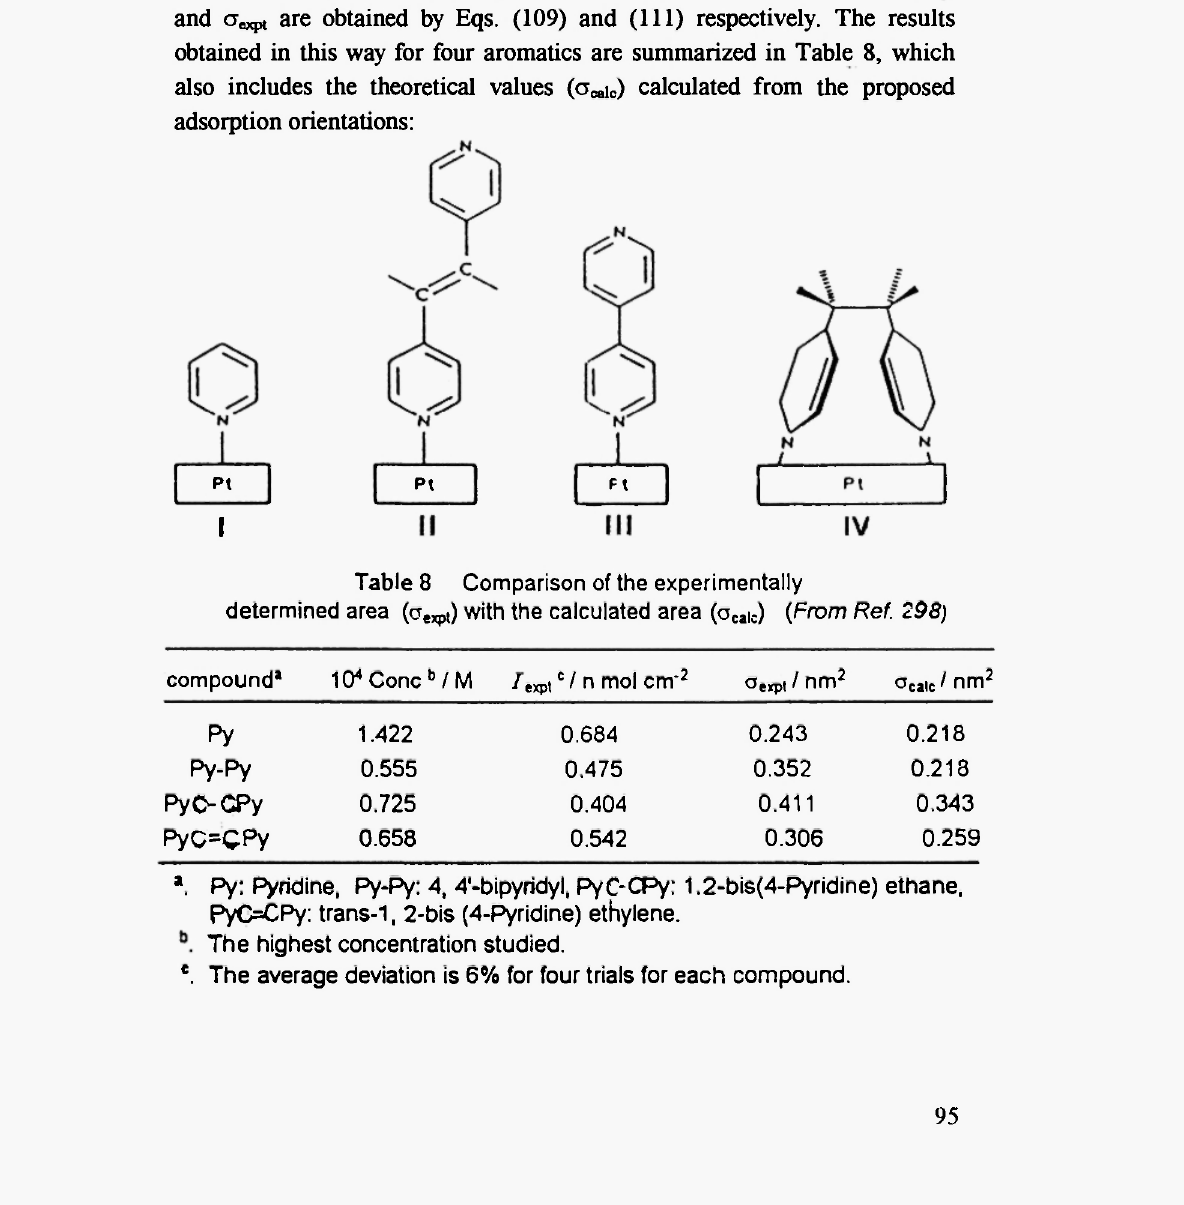
Comparison of the